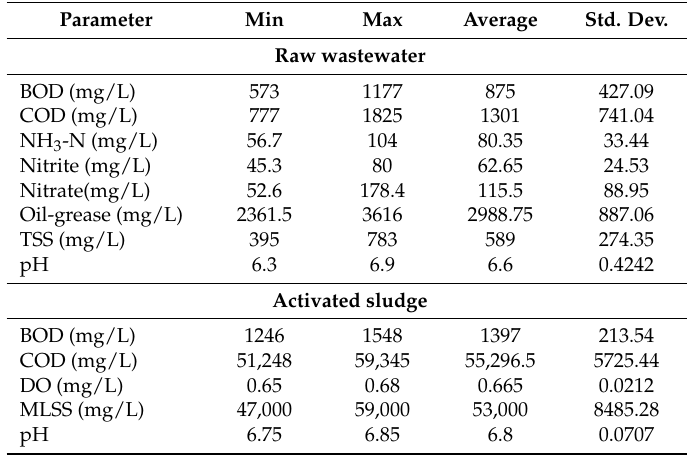
Table 1. Characteristics of raw wastewater and activated sludge (No. of samples = 7).